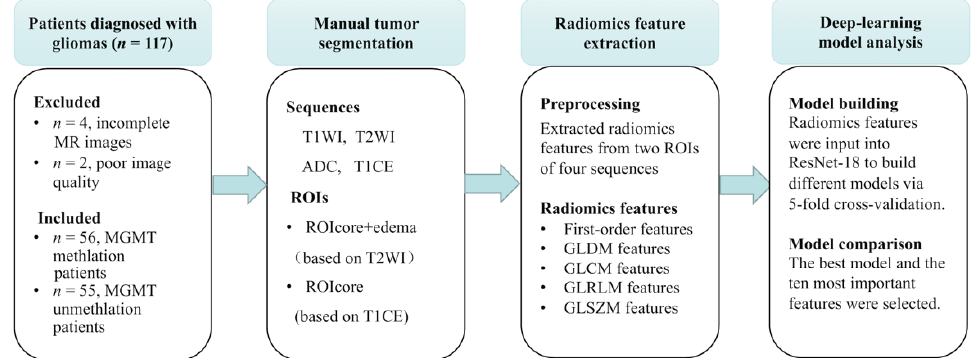
Figure 1. Workflow of our research. Radiomics features of 111 glioma patients were extracted from two regions of interest (the whole tumor area and the tumor core area) of four sequences, including T1 weighted image (T1WI), T2 weighted image (T2WI), apparent diffusion coefficient (ADC) maps, and T1 contrast-enhanced (T1CE) MR images were jointly fed into the ResNet-18. The performance of all models was compared using area under the curve (AUC) and average accuracy of validation cohorts. The 10 most important features of the best model were calculated via a class activation map. Abbreviations: oxygen 6-methylguanine-DNA methyltransferase (MGMT); residual network (ResNet); region of interest (ROI).